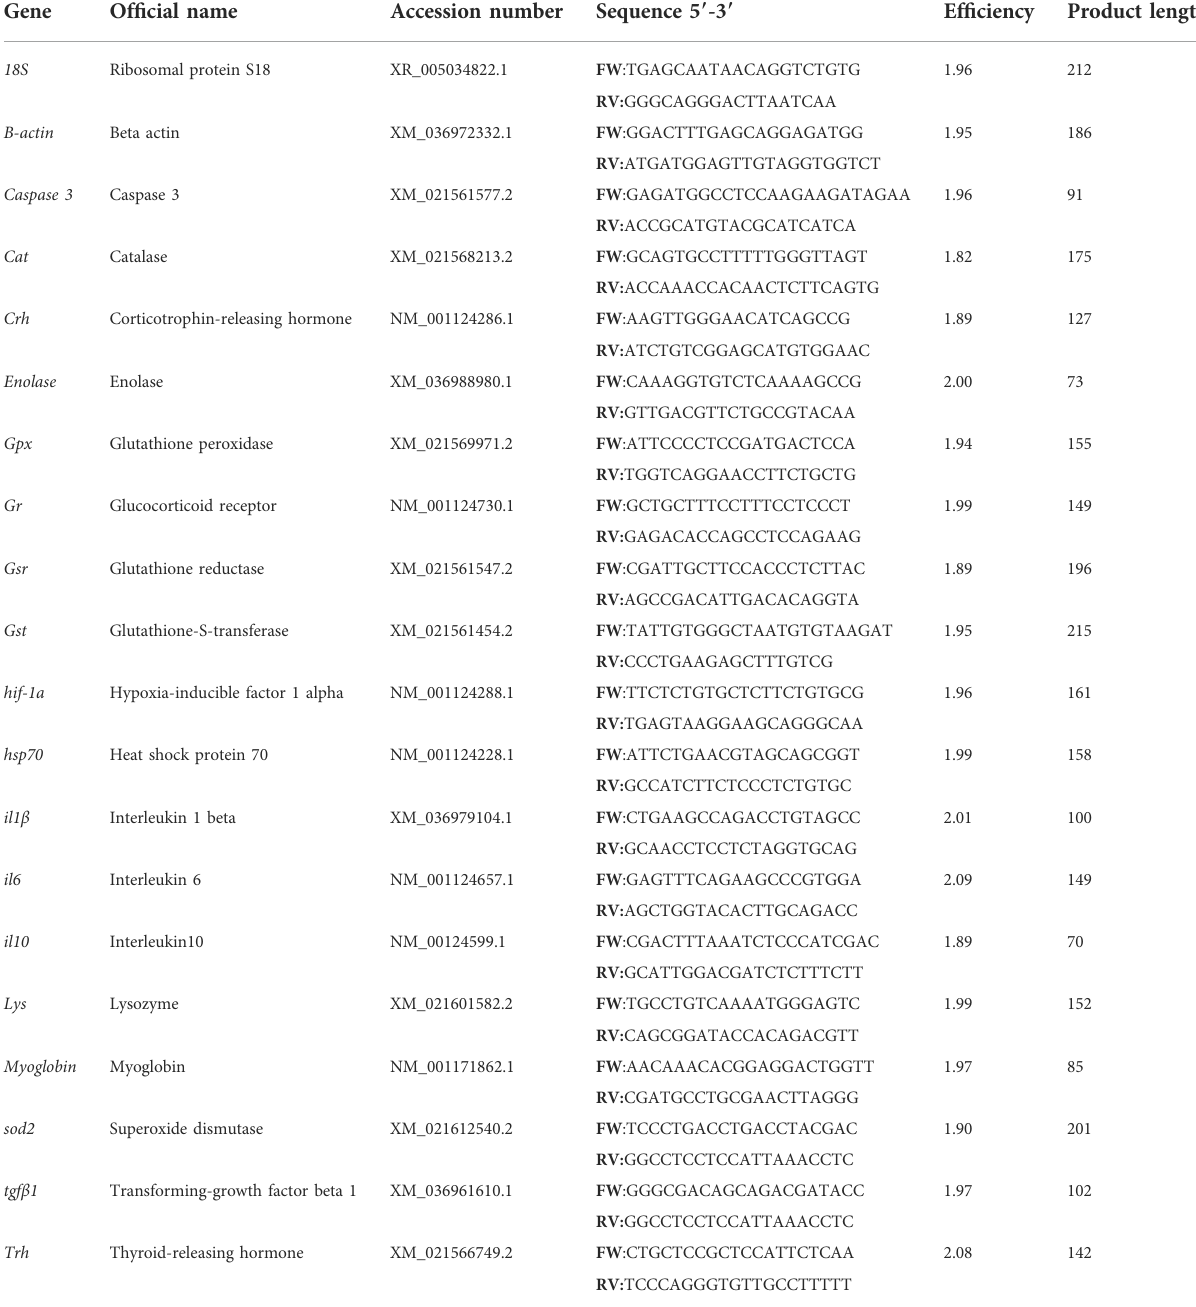
TABLE 1 Primers used for transcript-level analysis in rainbow